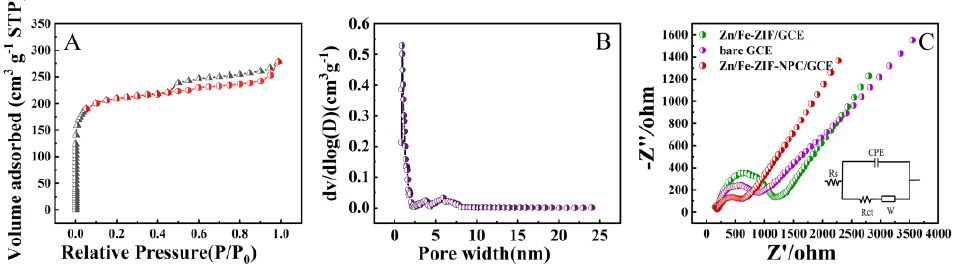
Figure 2. ( A ) N 2 adsorption/desorption isotherms of Zn/Fe-ZIF-NPC, ( B ) Pore size distributions of Zn/Fe-ZIF-NPC, ( C ) EIS of bare GCE, Zn/Fe-ZIF/GCE and Zn/Fe-ZIF-NPC/GCE in 0.1 M KCl (containing 5 mM [Fe(CN) 6 ] 3−/4− ). Zn/Fe-ZIF loading volume: 8 μ L; Zn/Fe-ZIF-NPC loading volume: 8 μ L.